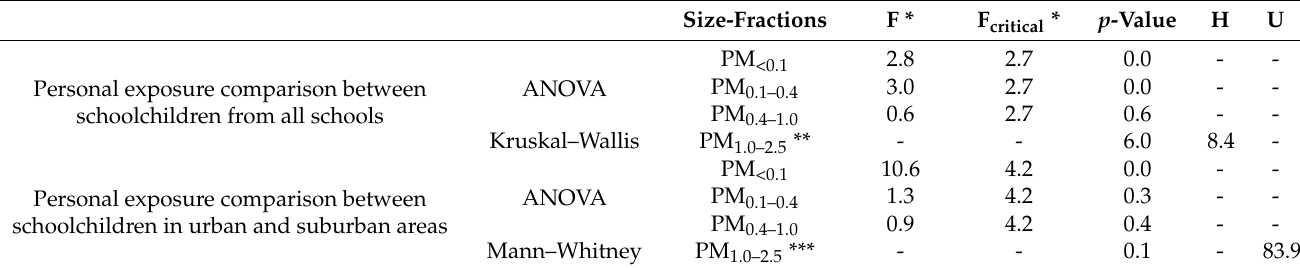
Table 4. Results of statistical tests of personal exposure to mass size-segregated particles to schoolchil- dren participants with a significance level α = 0.05.